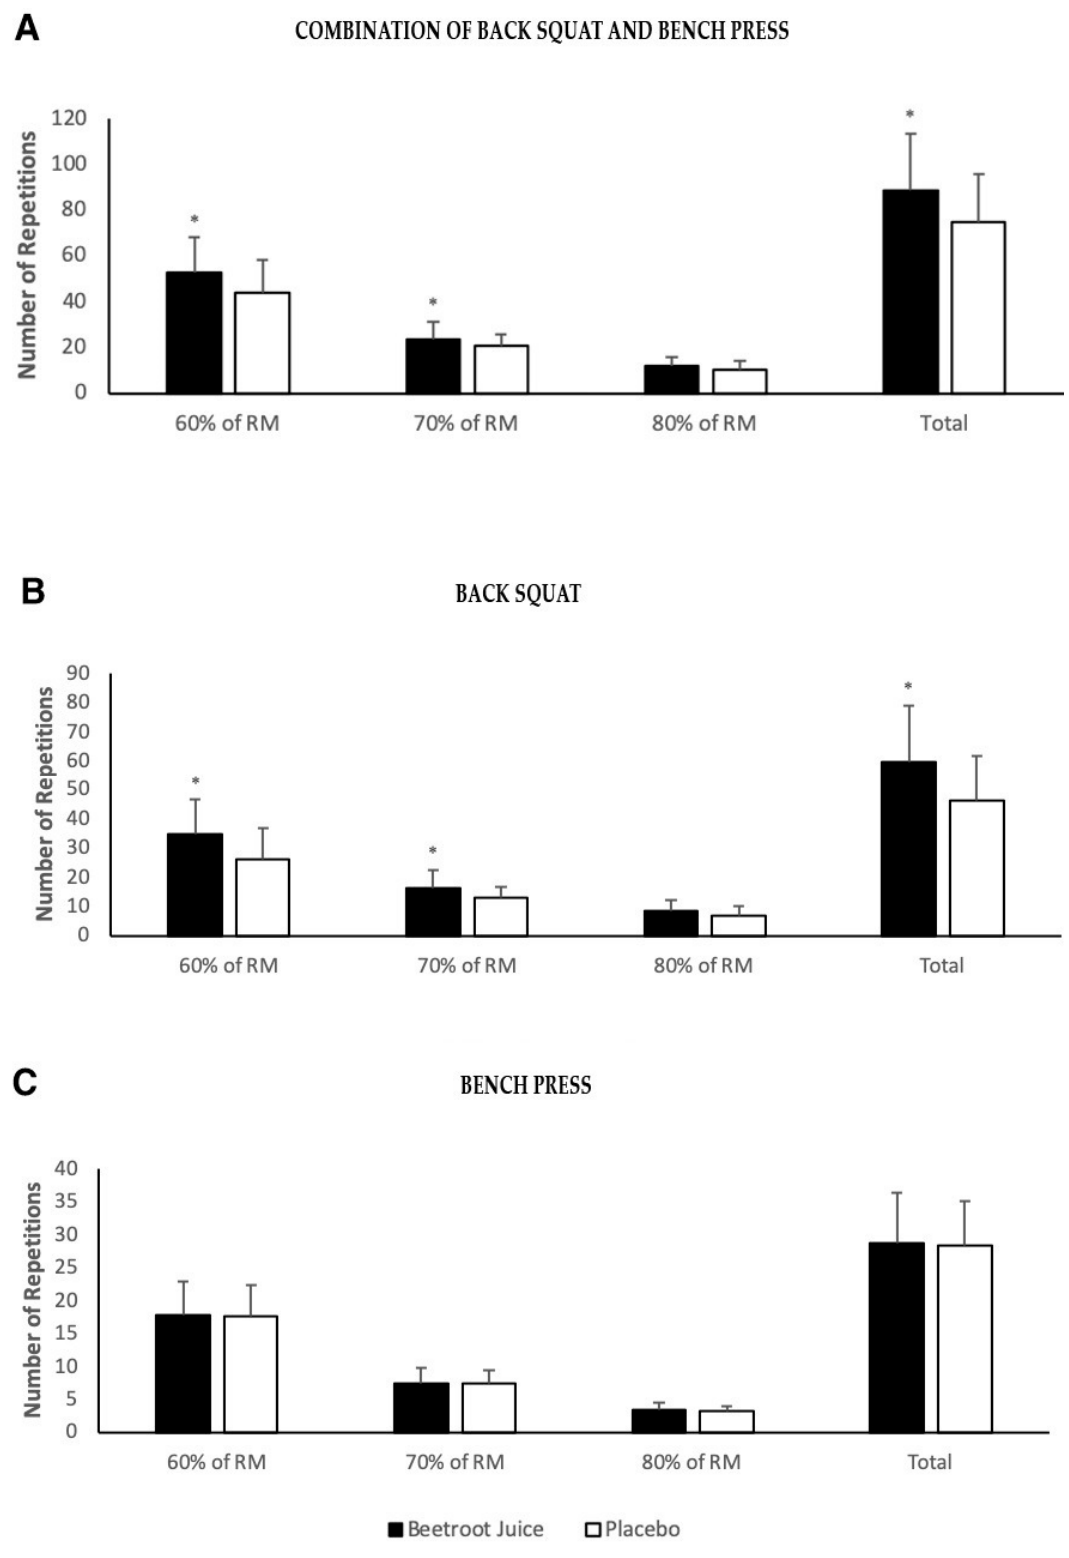
Figure 2. ( A ) Number of repetitions performed in the combination of back squat and bench press; ( B ) number of repetitions performed in back squat; ( C ) number of repetitions performed until concentric failure for each set of intensities 1-RM (60%, 70%, 80%) in bench press. RM: one-repetition maximum. (*) Significant di ff erence between beetroot juice (BJ) and placebo (PLA) conditions ( p < 0.05).